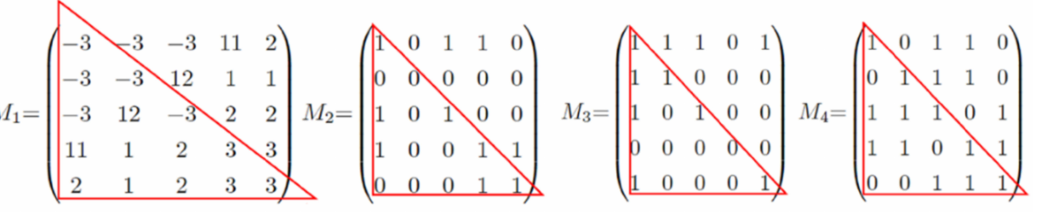
Figure 3. Example diagram of M 1 , M 2 , M 3 , M 4